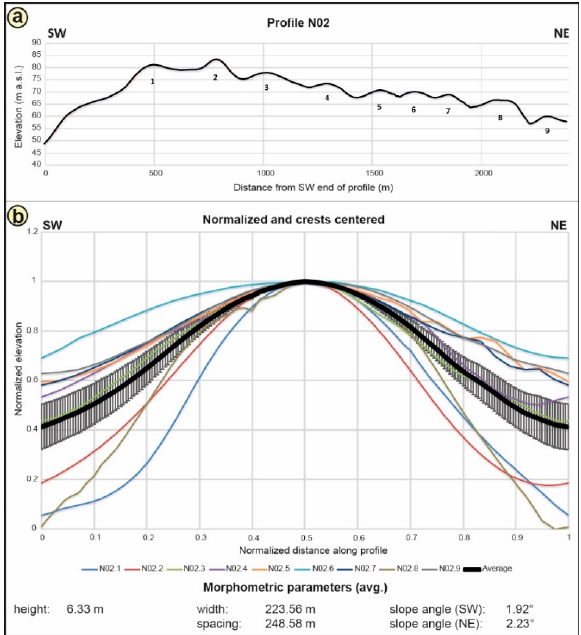
Figure 6. Profile N02 is shown as elevation profile from its distal (SW) to proximal (NE) end with the numbered ridge crests ( a ); The stacked profiles of the elevation profile include the average graph (thick black graph) and error bars (±1 standard deviation) ( b ). The morphometric parameters—mean height, width, spacing, and slope angles—are shown below.